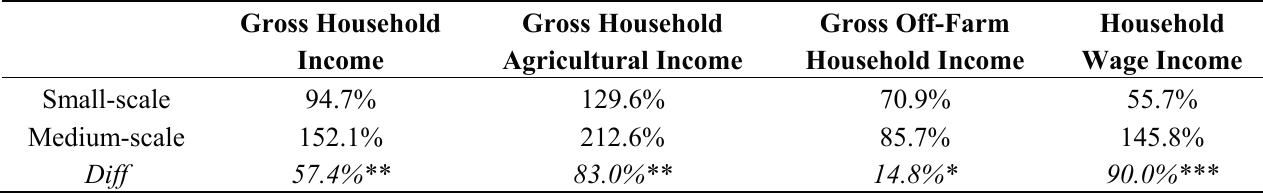
Table 4. Percent change in average real income for small-scale and medium-scale farmers by source 2001–2012. Source: authors calculations from SS 2001 and RALS 2012. CPI comes from Zambian Central Statistical